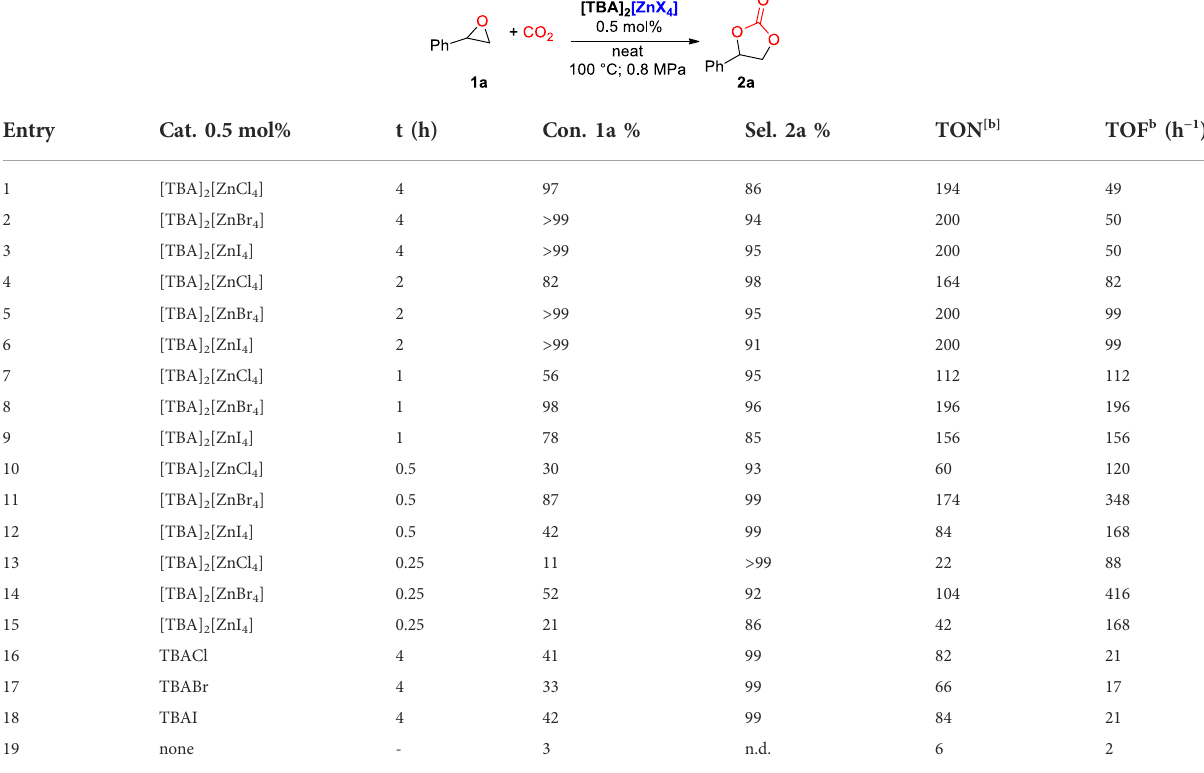
TABLE 2 Cycloaddition of CO 2 to styrene oxide catalysed by the tetrahalogenozincate-salts a .